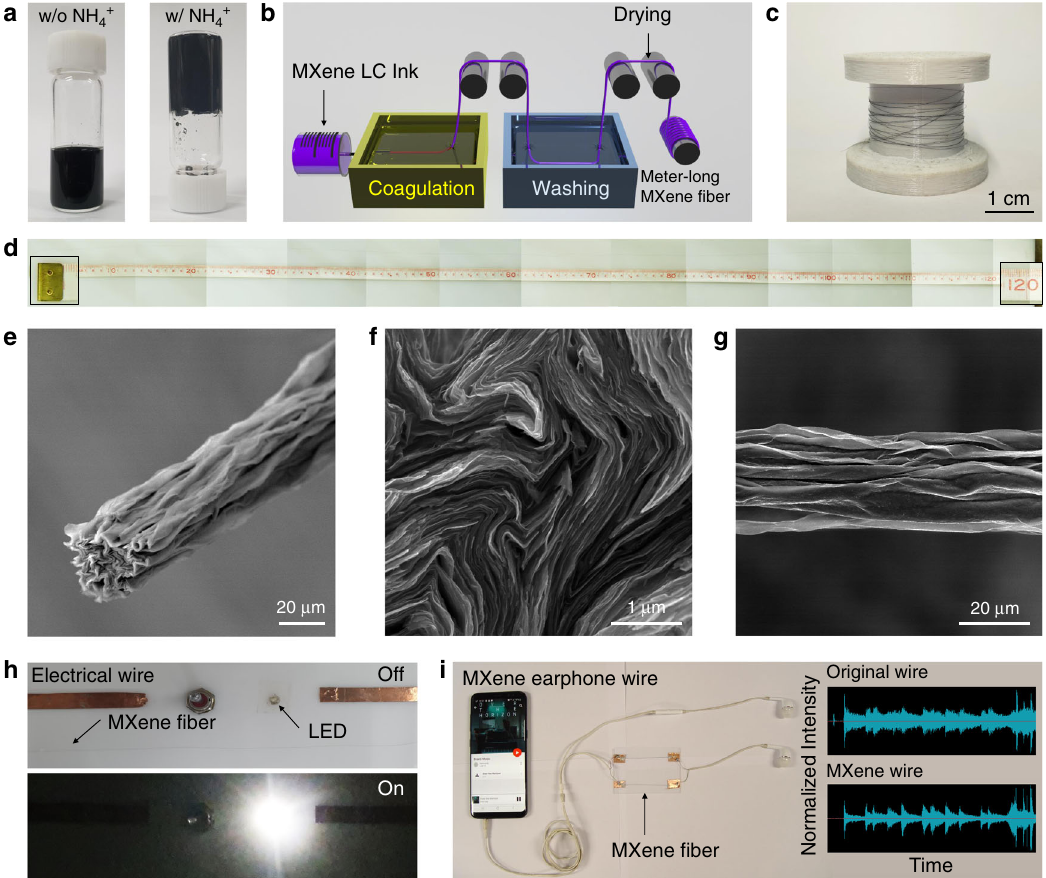
Fig. 4 Wet-spinning of the pure Ti 3 C 2 T x MXene fi ber. a Gelation of the Ti 3 C 2 T x MXene dispersion by NH 4 + ions. The sol – gel transition was identi fi ed via the vial-inversion method. b Schematic illustration of the wet-spinning process of the Ti 3 C 2 T x MXene fi ber. c Meter-long Ti 3 C 2 T x MXene fi ber wound on the bobbin. d Continuous wet-spinning allowed fabrication of over 1 m (1.2 m) of the Ti 3 C 2 T x MXene fi ber. SEM images of Ti 3 C 2 T x MXene fi ber: e overall, f in cross-section, and g side-section views. Ti 3 C 2 T x MXene fi ber applied as h an electrical wire and i an earphone wire.